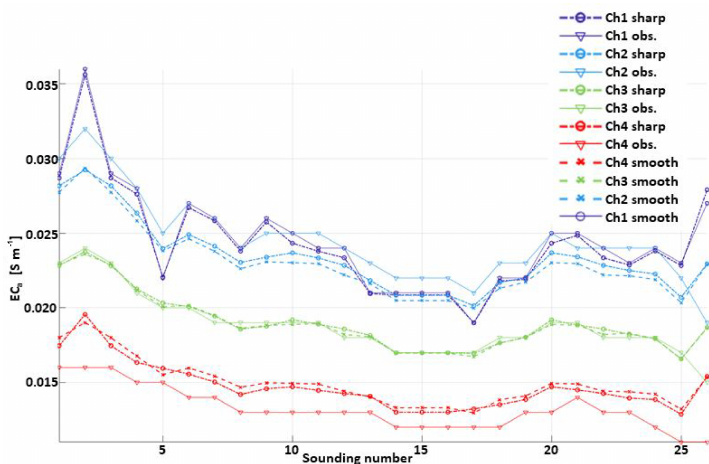
Figure 3. Comparison of the data fitting associated with the sharp and smooth inversions applied to the dataset 100-6dS (Fig. 2). The calculated data corresponding to the sharp and smooth results are shown together with the observations for each of the four measured channels (heights).